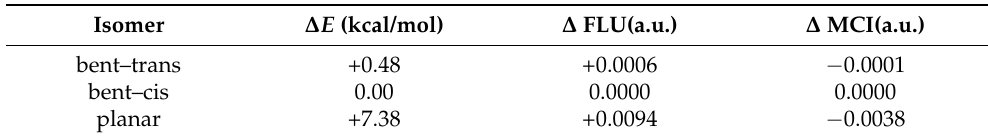
Table 5. Energies and aromaticity indices for the different isomers of the AZH (DCR) dimers. All values are reported relative to the most stable isomer (bent–cis).